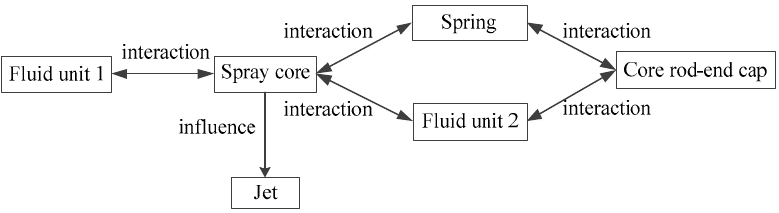
Figure 4. Interaction between the units in the fire-fighting jet system with the adaptive gun head.